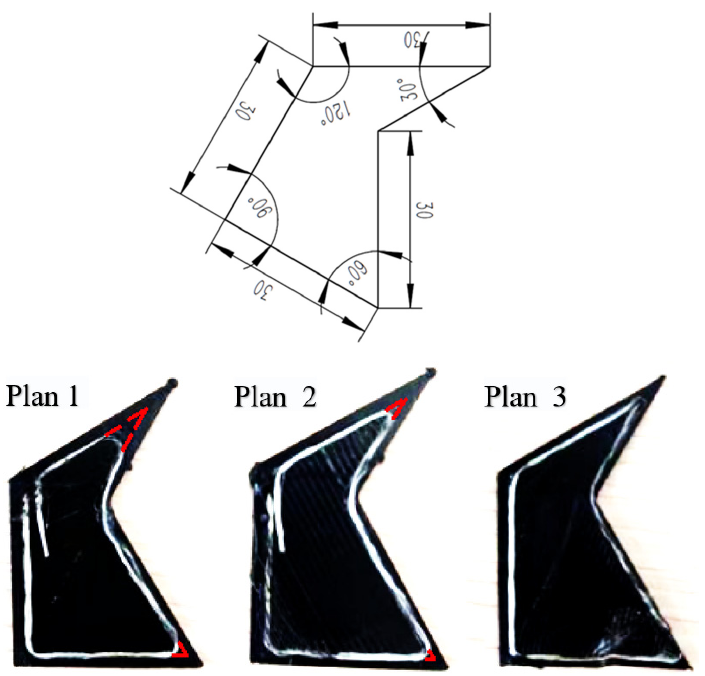
Figure 9. Fit evaluation of typical printing specimens. The fitting degree is used to evaluate the effect on printing specimens.